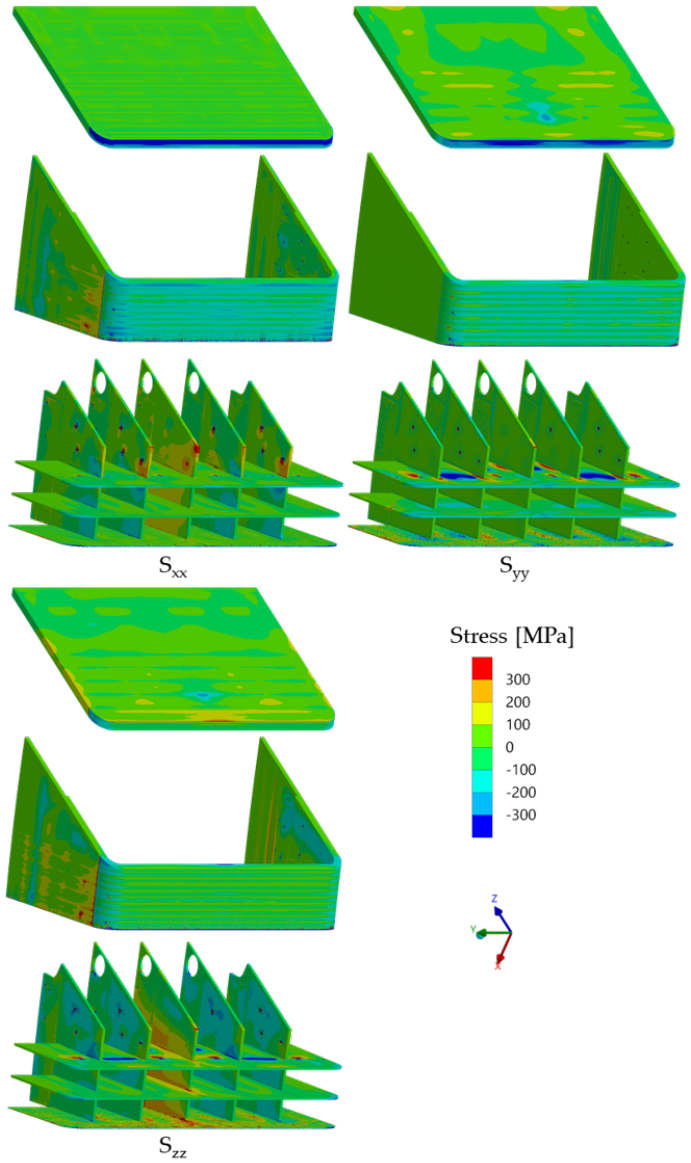
Figure 20. Spatial distribution of the stress tensor normal components within Eurofer